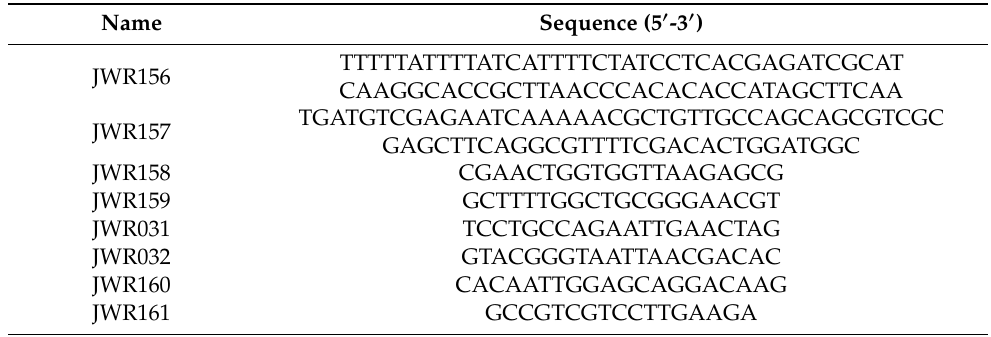
Table 3. Oligonucleotides used in this